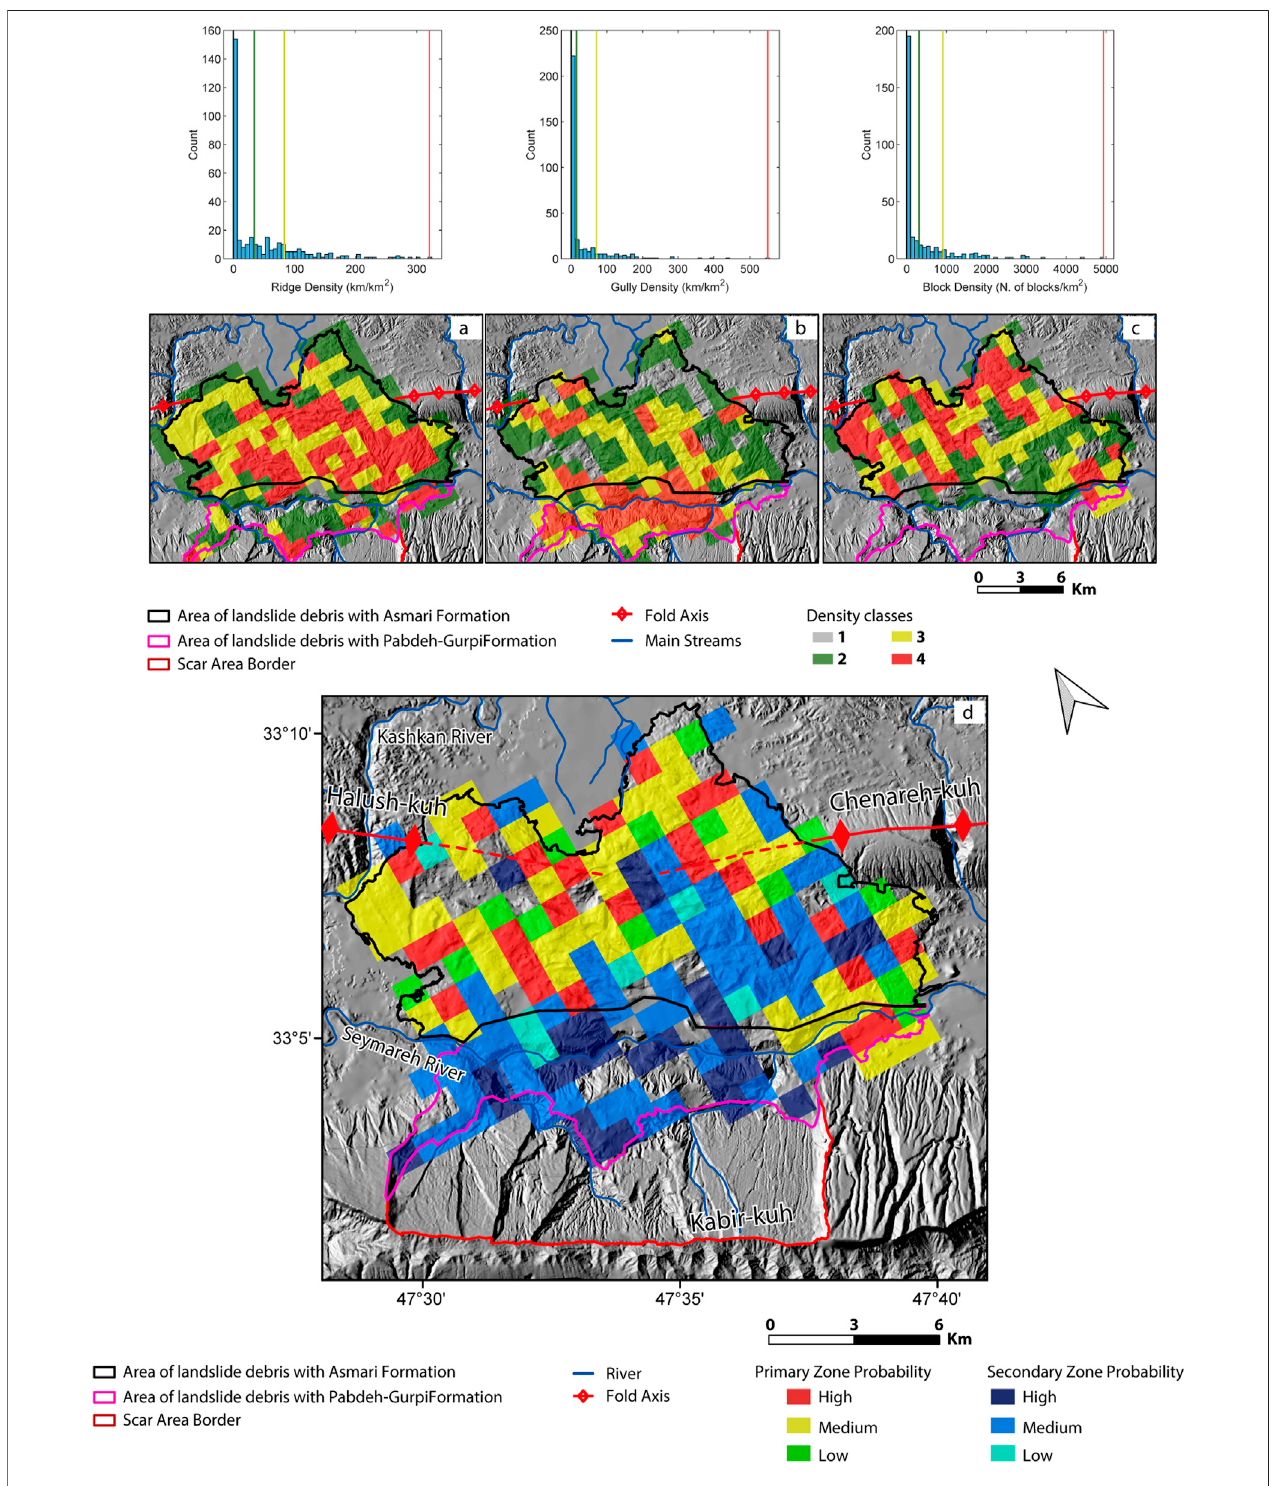
FIGURE 4 | Density maps of (A) ridges, (B) gullies, and (C) blocks and related histograms. (D) Probability model of primary and secondary zones based on the combination of the aggregate densities obtained following the matrix of probability reported in Table 1 and the association described in Table 2 . The coordinate reference system is